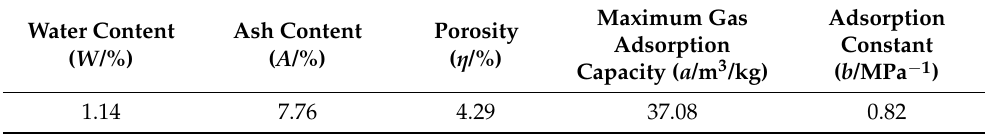
Table 3. Industrial analysis and gas basic